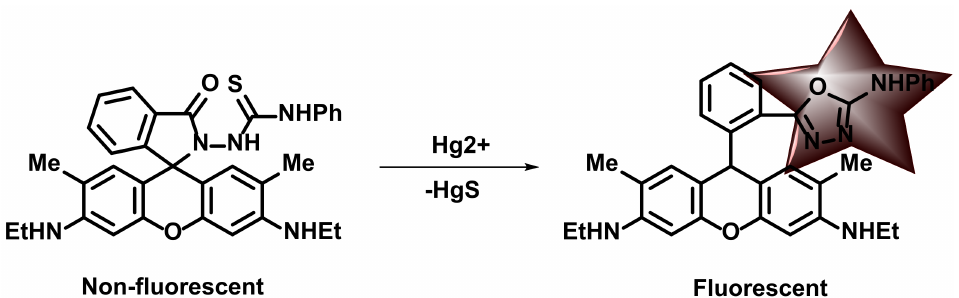
Figure 14. Conversion of non-fluorescent to strongly fluorescent rhodamine-based system by mercury ions. Reproduced with permission from [37] by American Chemical